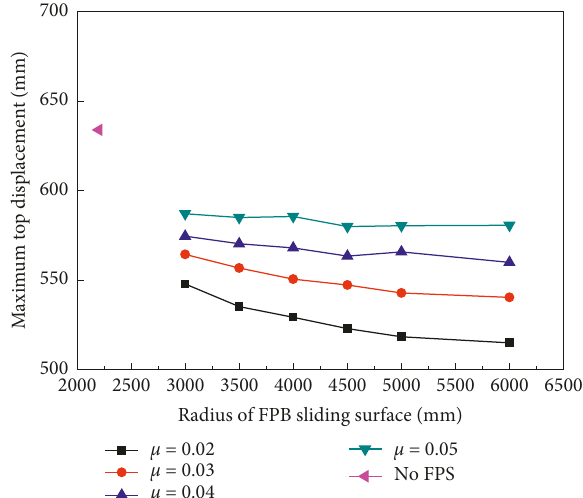
Figure 19: The maximum top displacement of T2 tower with R and μ in the X direction under L6501S wave.